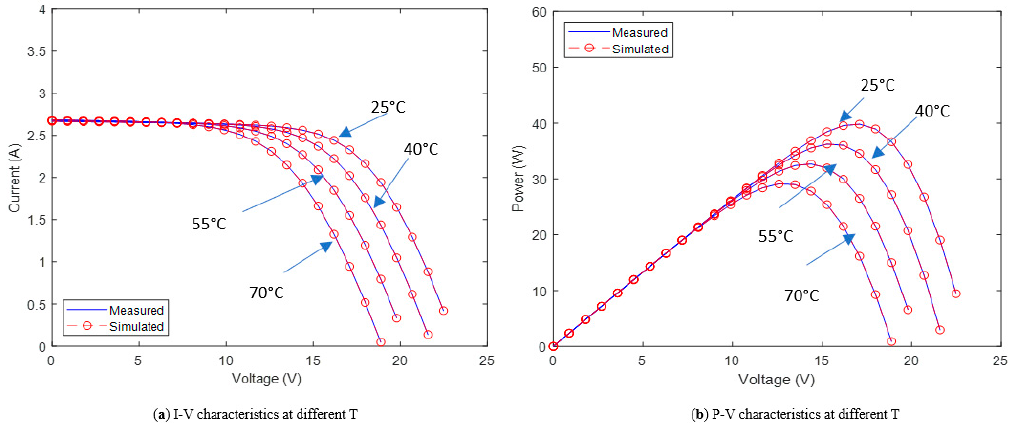
Figure 18. Depiction of the principal characteristics on the ST40 module at G = 1000.